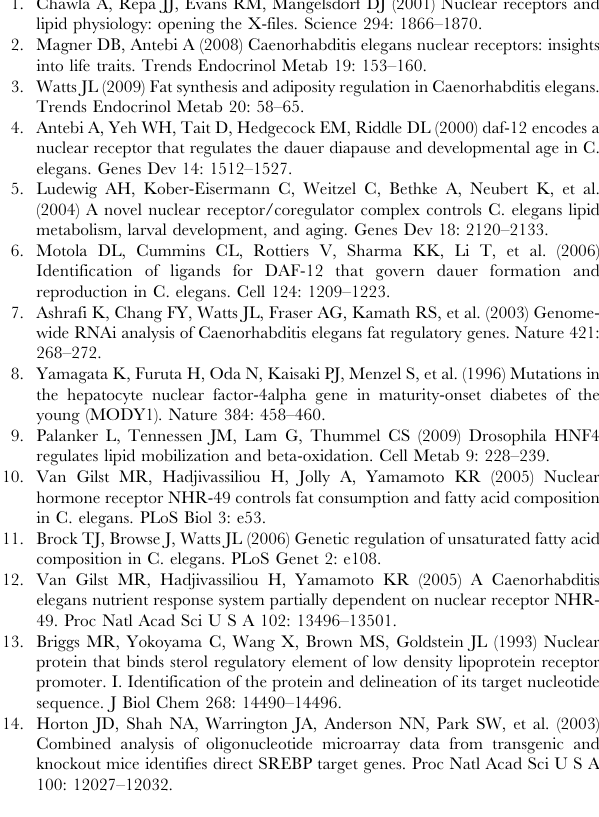
Figure S1 Characterization of sbp-1(ep79) . (A) Simplified scheme of sbp-1 gene structure. White arrows are exons and black lines are introns. sbp-1 consists of 13 exons. Exon 6 of sbp-1 encodes a helix- loop-helix (HLH) domain indicated by red rectangle and ep79 deletion removed 2181 base pairs indicated by blue rectangle.